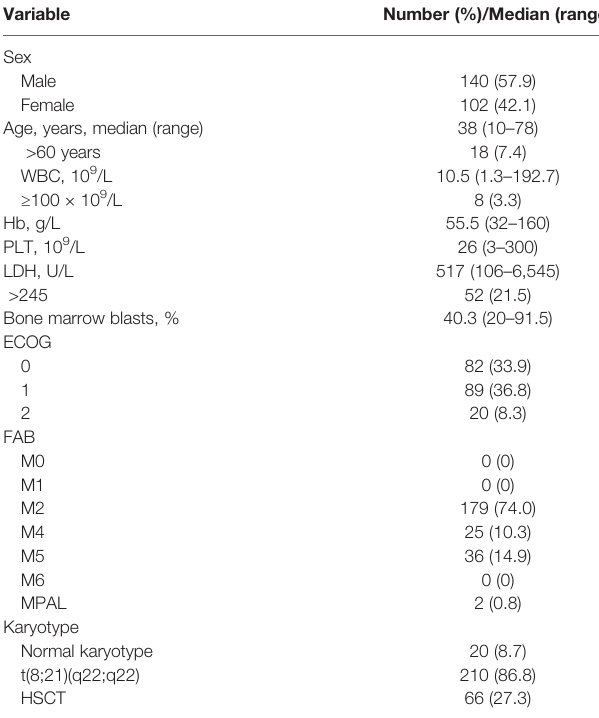
WBC,whitebloodcell;Hb,hemoglobin;PLT,plateletcount;LDH,lactatedehydrogenase; ECOG, Eastern Cooperative Oncology Group; FAB, morphology according to French – American – British classi fi cation; MPAL, mixed phenotype acute leukemia; HSCT, hematopoietic stem cell